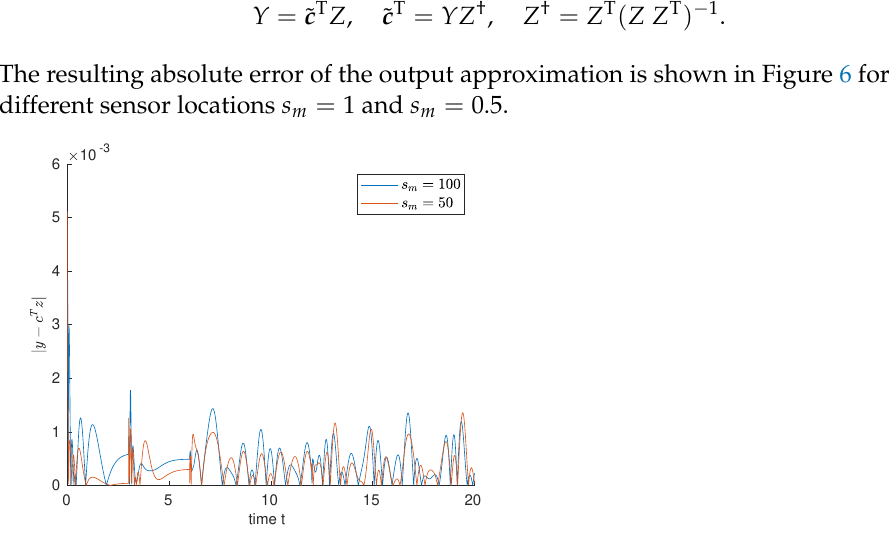
Figure 6. Output approximation error for the training data for the two different sensor locations s m . It can be seen that a good correspondence is achieved for both sensor